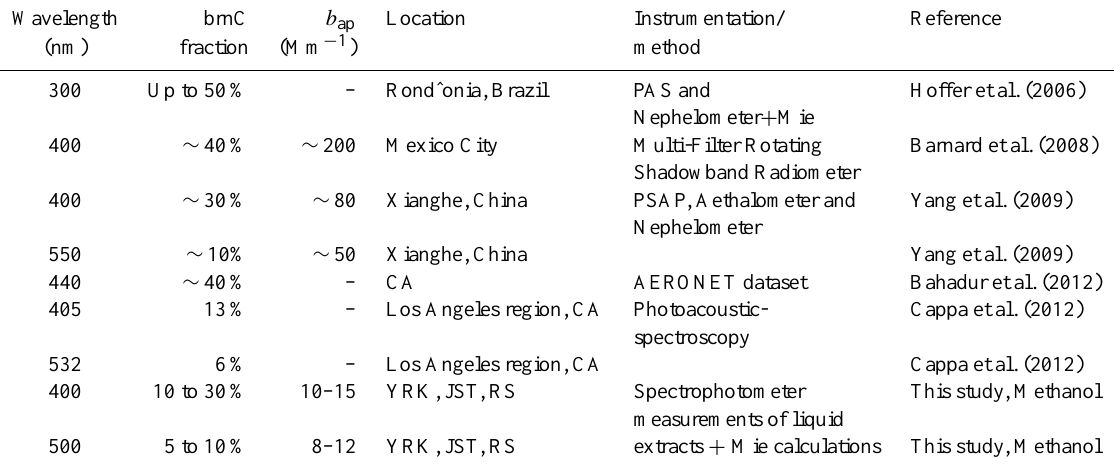
Table 6. Comparison of estimated brown carbon contribution in the present study with previous